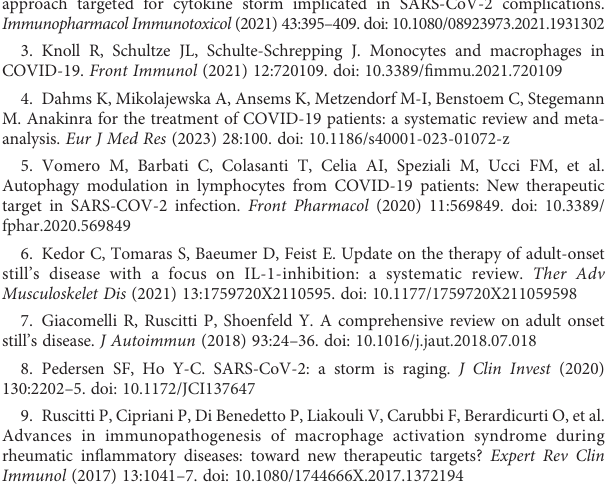
were excluded. The expression of surface markers CD206 and CD80 were analyzed on CD68-positive cells. (B) M1 and M2 Macrophages Polarization. Analysis of CD80 and CD206 expression, reported as mean fl uorescence intensity, in monocyte-derived macrophages polarized towards M1 and M2 phenotype. MFI= mean fl uorescence intensity. SUPPLEMENTARY FIGURE 2 Cytokines and chemokines levels in supernatants of M1 (A) and M2 (B) macrophages from COVID-19 patients treated in vitro with PD1. Data are reported as pg/mL and represent 12 independent experiments. SUPPLEMENTARY FIGURE 3 Cytokines and chemokines levels in supernatants of M1 (A) and M2 (B) macrophages from AOSD patients treated in vitro with PD1. Data are reported as pg/mL and represent 10 independent experiments. SUPPLEMENTARY FIGURE 4 Representative assay ampli fi cation curves of SARS-CoV-2 RNA of one sample obtained from in vitro experiments on monocytes-derived macrophages from COVID-19 patients. Green line represents the ampli fi cation internal control, red line represents the ampli fi cation for SARS-CoV2 E (Envelope) gene while the blue line shows the ampli fi cation for SARS-CoV2 S (Spike)